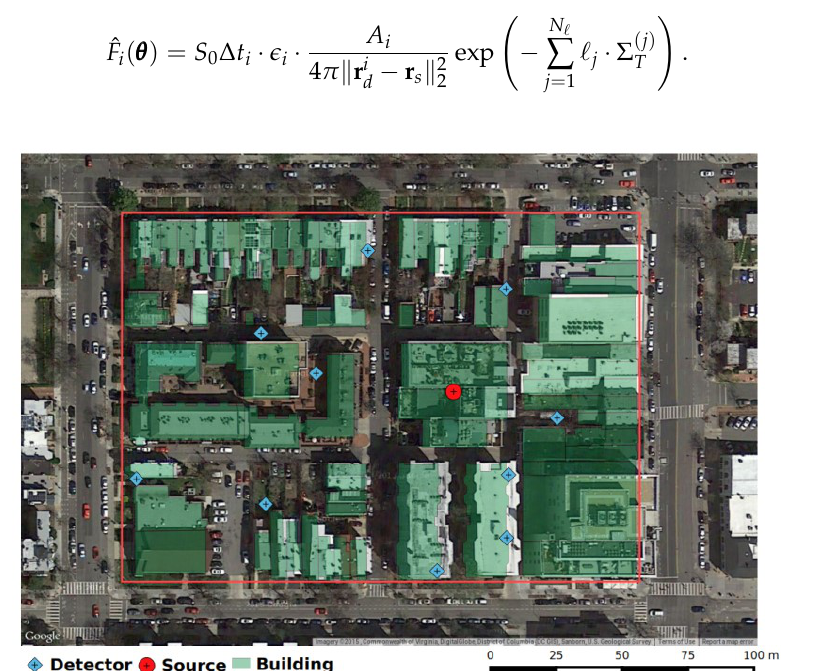
Figure 1. Satellite image of problem domain with model geometry overlaid (Imagery c (cid:13) 2016 Commonwealth of Virginia, DigitalGlobe, District of Columbia (DC GIS), Sanborn, U.S. Geological Survey, Map data c (cid:13) 2016 Google). The figure marks indicate possible detector and source